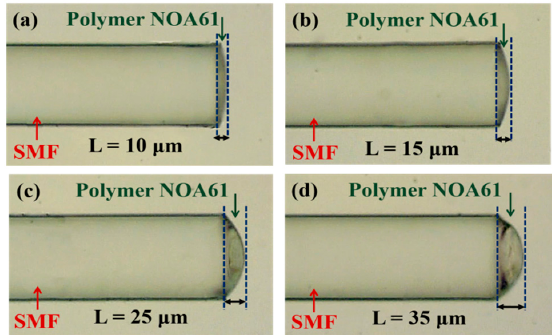
Figure 3. Micrographs of the proposed HPFFPIs with various hot-polymer lengths: ( a ) L = 10; ( b ) L = 15; ( c ) L = 25; ( d ) L = 35 μ m.